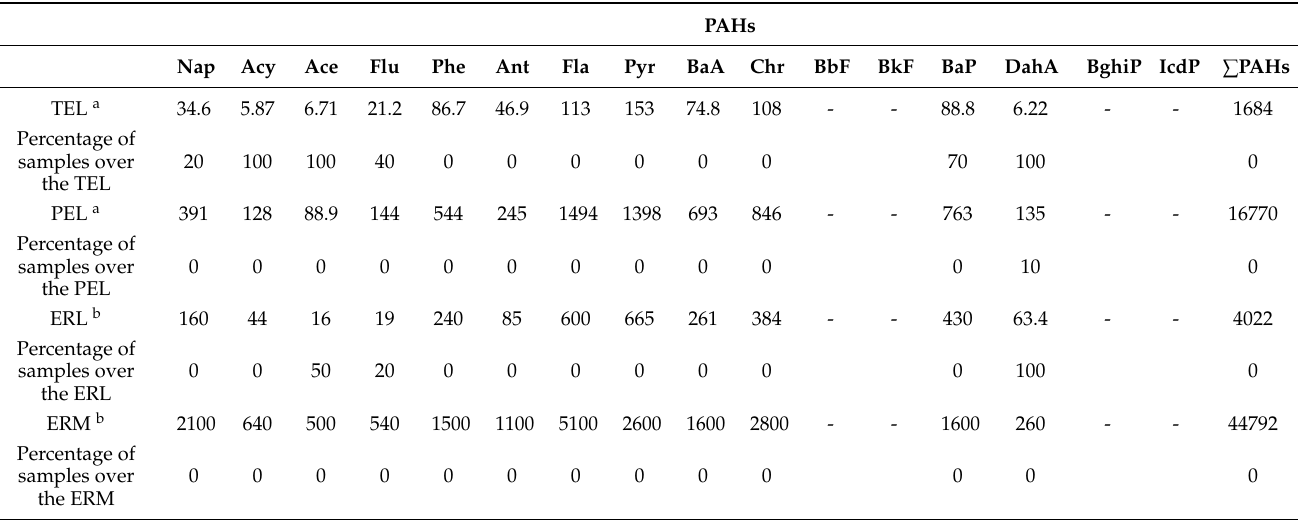
Table 3. A comparison of the TEL, PEL, ERL, and ERM guideline values ( µ g Kg − 1 ) for polycyclic aromatic hydrocarbons and the data found for the Sele River, southern